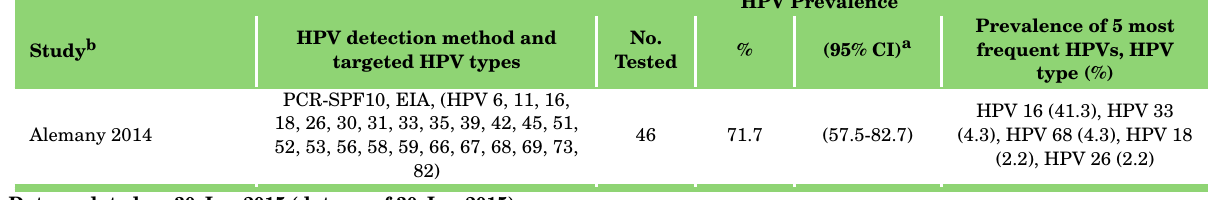
Table 29: Studies on HPV prevalence among vaginal cancer cases in India